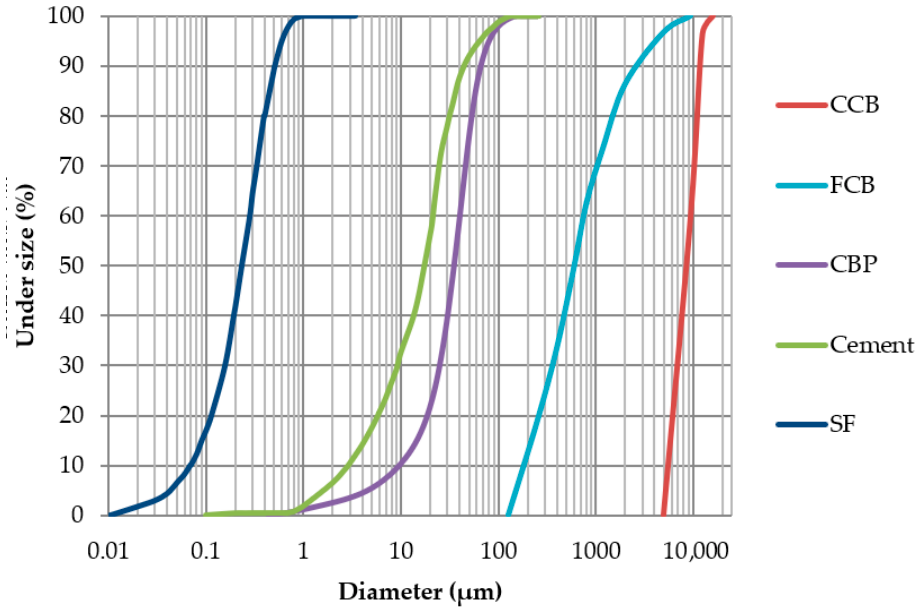
Figure 2. Particle size distributions of coarse crushed clay brick aggregate (CCB), fine crushed clay brick aggregate (FCB), clay brick powder (CBP), cement, and silica fume (SF).